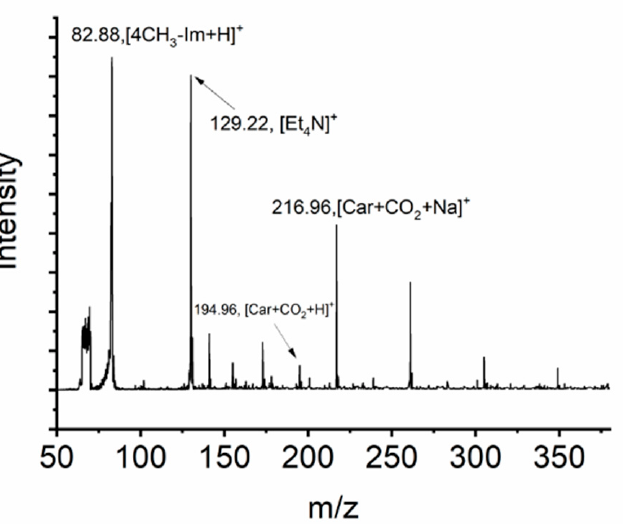
Figure 8. The electrospray ionization mass spectrum (ESI-MS) of CO 2 loaded [Et 4 N] [Car]:4CH 3 -Im (1:2) solvent.